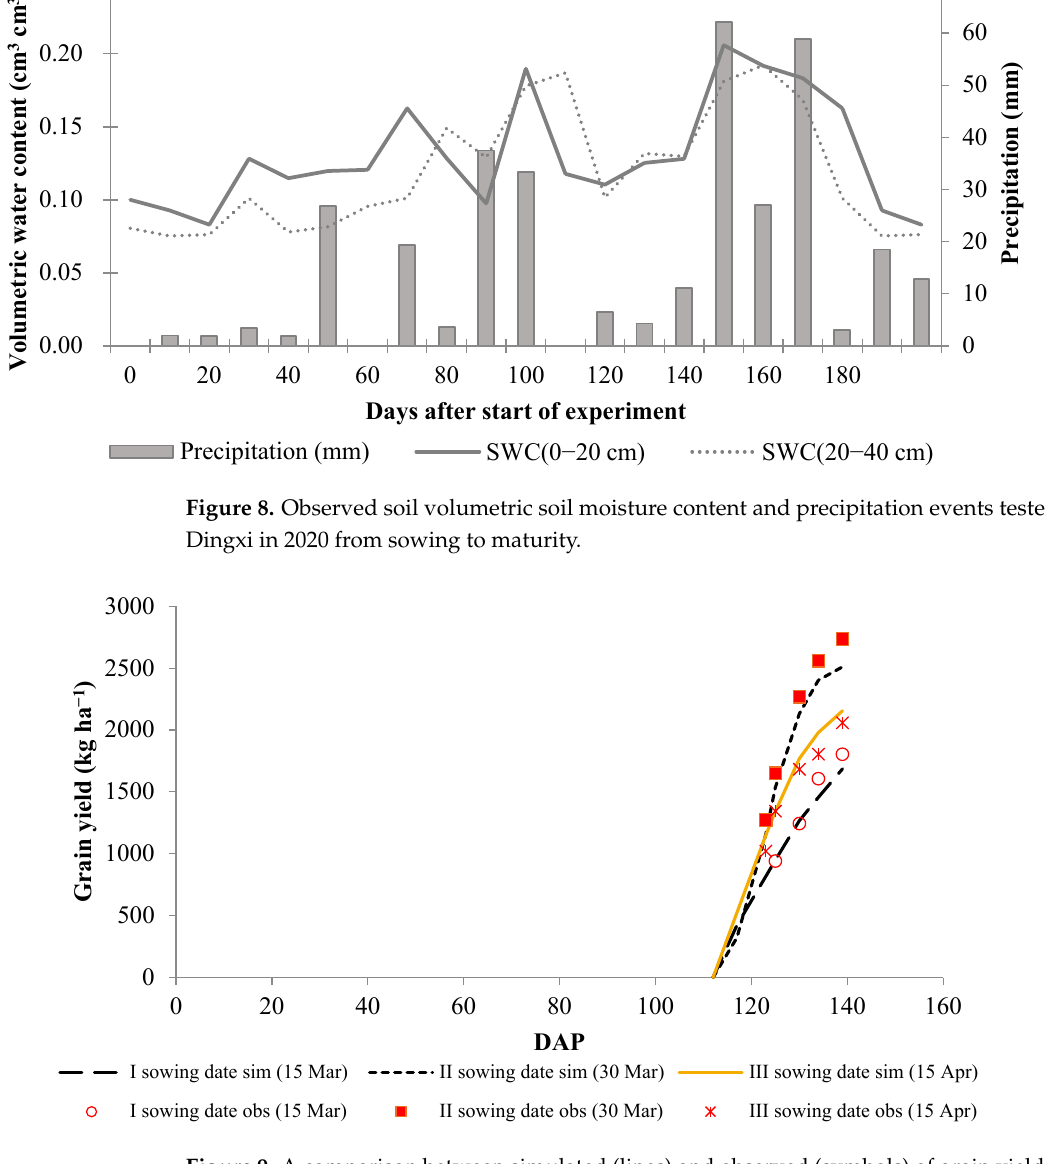
Figure 9. A comparison between simulated (lines) and observed (symbols) of grain yield for the three